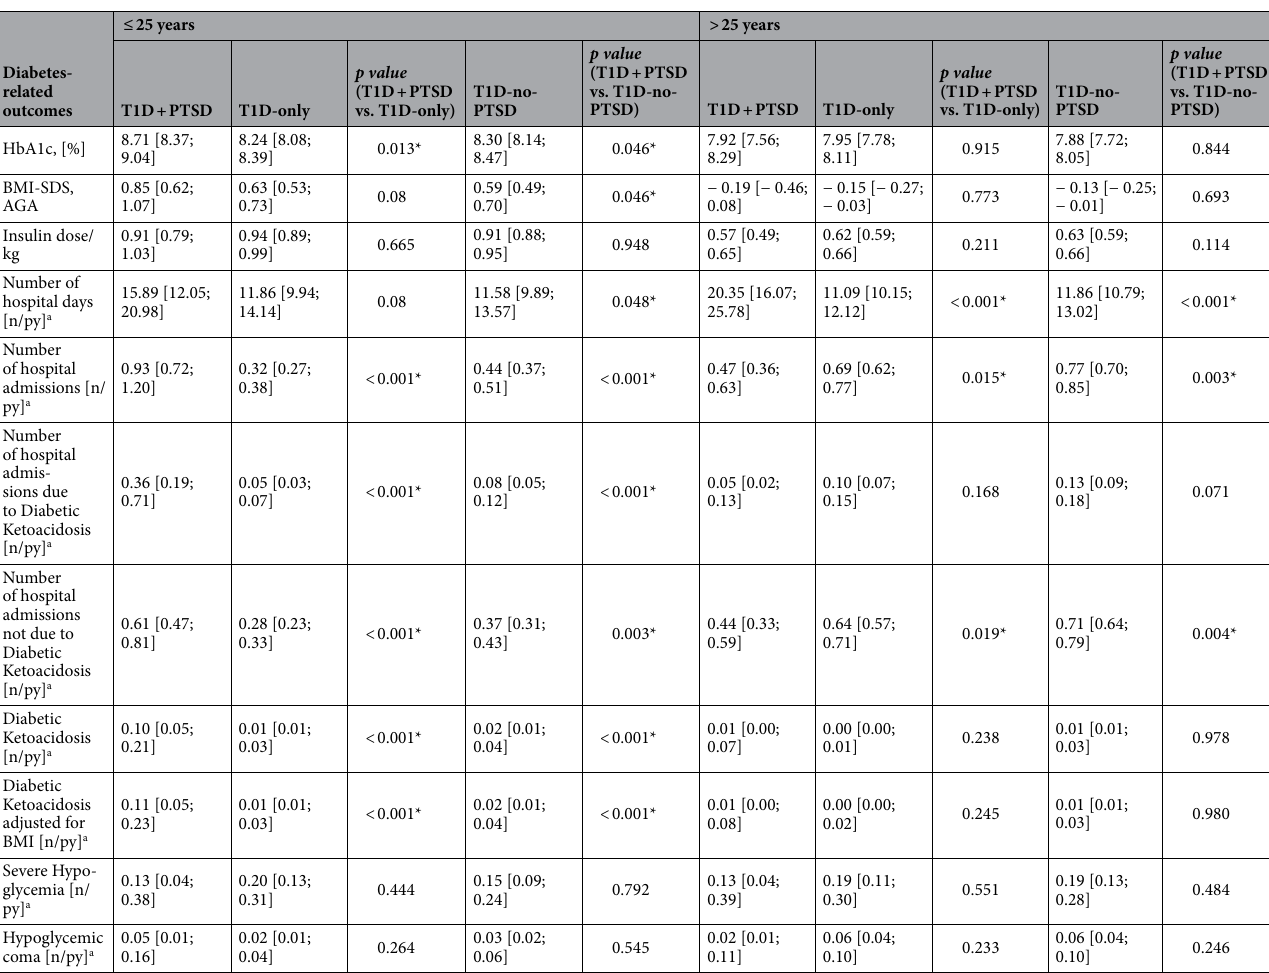
Table 4. Diabetes-related outcomes of patients with T1D (ages ≤ 25 and > 25 years) with PTSD compared to patients with T1D without PTSD (with or without other mental comorbidities) and compared to patients with T1D without a mental comorbidity, matched for demographics. All data are presented in: estimated mean [lower confidence interval; upper confidence interval] of the matched cohort (matching variables: age, gender, diabetes duration, therapy and migration background). T1D type 1 diabetes, PTSD posttraumatic stress disorder, T1D-only patients with T1D without comorbid mental disorder, T1D + PTSD patients with T1D and PTSD, with or without other mental disorder, T1D-no-PTSD patients with T1D without PTSD, with or without other comorbid mental disorder, HbA1c Hemoglobin A1c, BMI body-mass index, SDS standard deviation score, AGA Arbeitsgemeinschaft Adipositas im Kindes- und Jugendalter; a Number of events per patient years. *Significant (p <